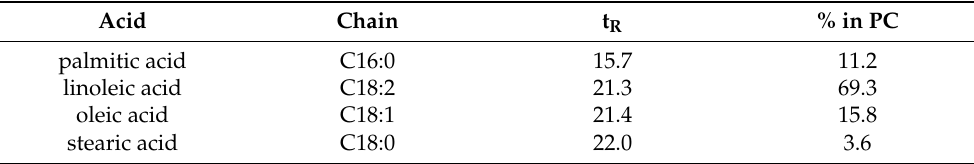
Table 3. Fatty acid composition of PC (results obtained by GC analysis reported in Figure